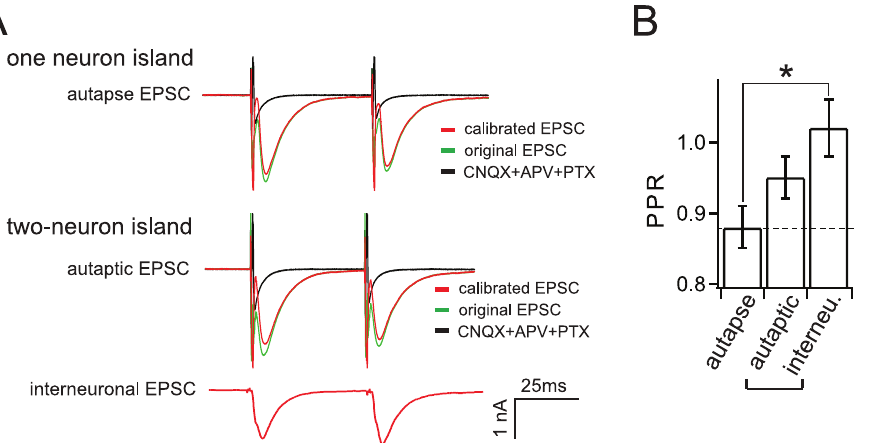
Figure 4. Interneuronal synapses display an enhanced paired-pulse ratio (PPR) compared to autapses. (A) Representative paired-pulse EPSCs recorded from autapses and autaptic and interneuronal synapses in two-neuron micronetworks. The calibrated EPSC was calculated by subtracting the offset current, determined by stimulation in the presence of CNQX to block AMPA receptors, from the original EPSC. (B) The PPR, determined by dividing the second EPSC by the first, is larger in two-neuron micronetworks (autaptic: 0.95 6 0.03; interneuronal: 1.02 6 0.04) than in autapses (0.88 6 0.03). Interneuronal synapses exhibited the highest PPR (n=18 autapses, 20 autaptic synapses, and 20 interneuronal synapses. Statistical significance was determined by one-way ANOVA and Newman-Keuls post-hoc test. *p , 0.05. All data shown represent mean 6 SEM.